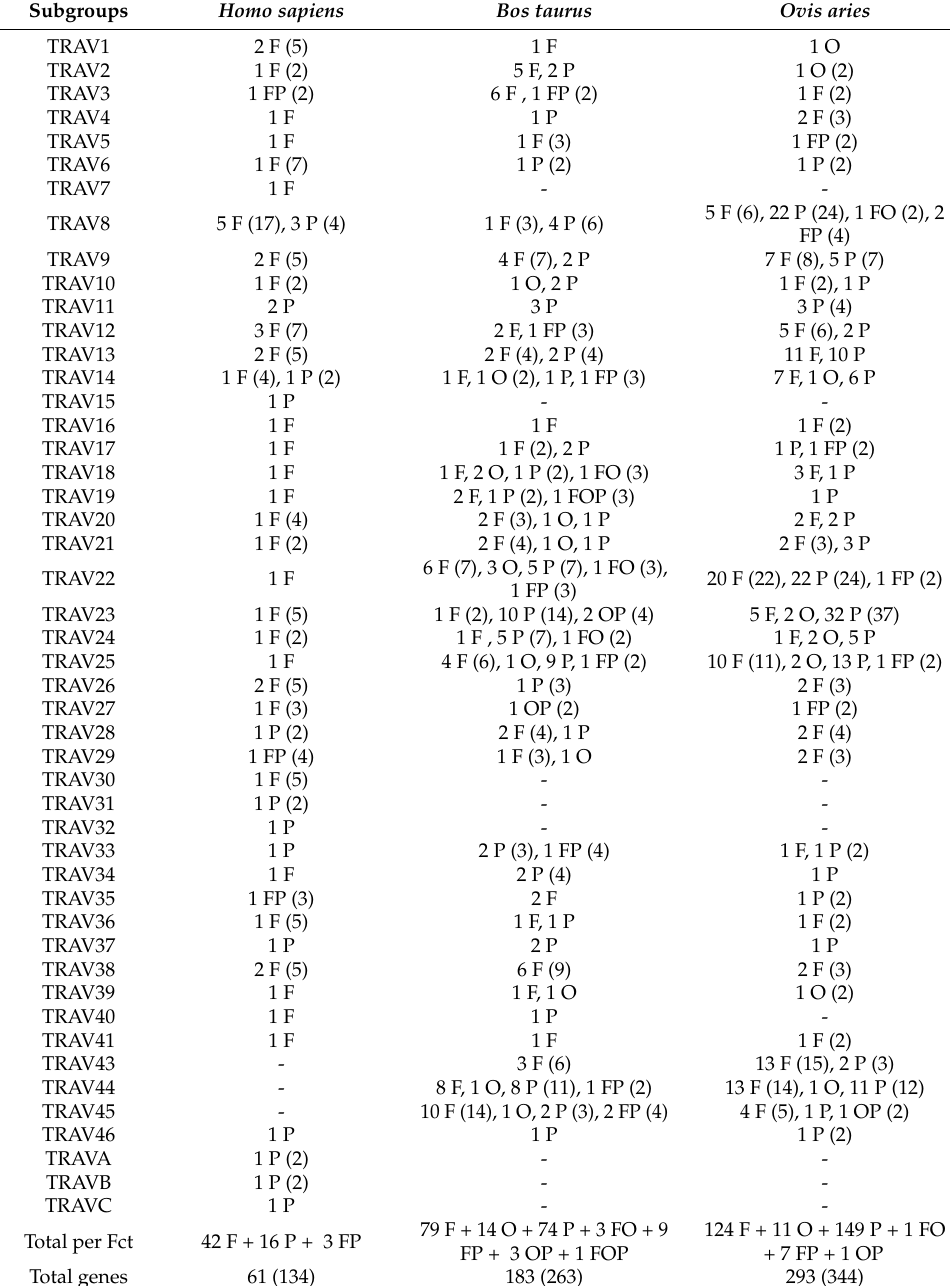
Table 7. IMGT Potential germline repertoires of the TRAV subgroups in human ( Homo sapiens ), bovine ( Bos taurus ) and sheep ( Ovis aries